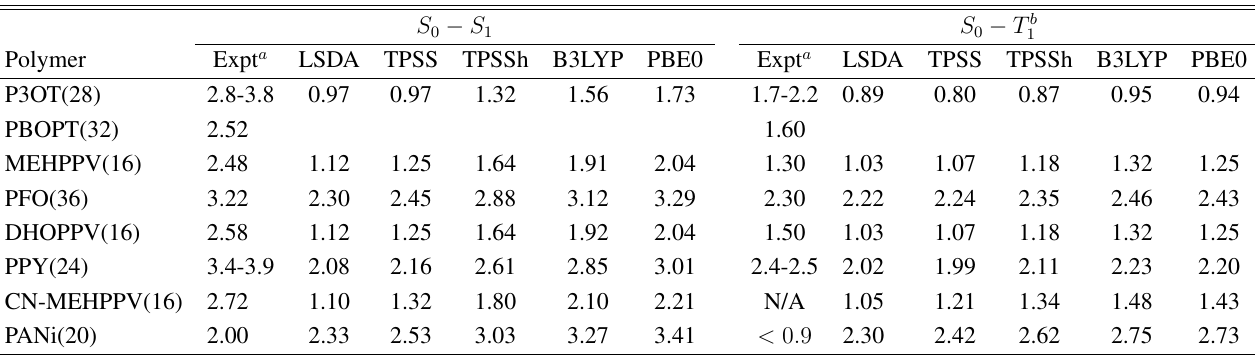
Table 21. The same as Table 19, but in benzene solution. The solvent effects are taken into account through PCM (polarizable continuum model)